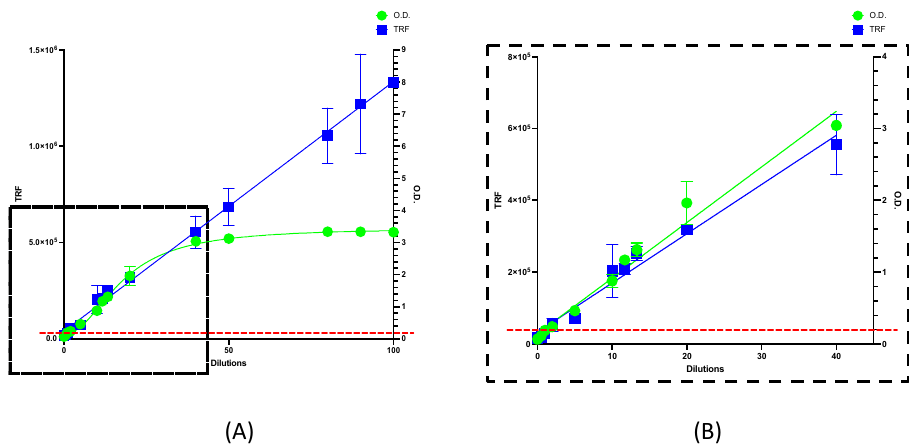
Figure 1. DBS-DELFIA vs. ELISA dilutions linearity range. ( A ) DBS-DELFIA dilutions results are expressed as TRF, whereas ELISA results are expressed as OD values. ( B ) Magnification of rectangular black dashed section highlighting ELISA linearity range. Red dashed line expressed ELISA cut-off value (0.2 OD).